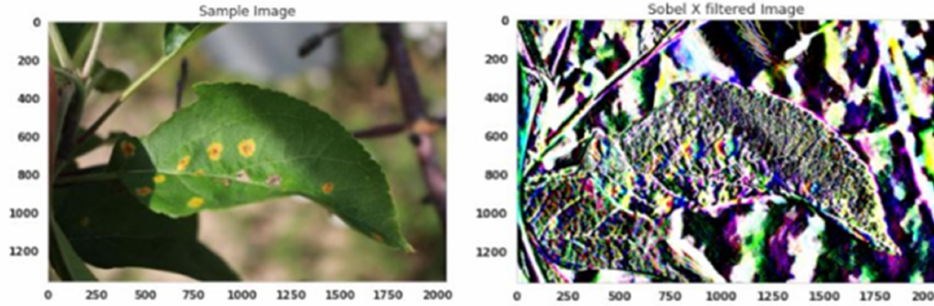
Figure 5. The Sobel Filtering Method.